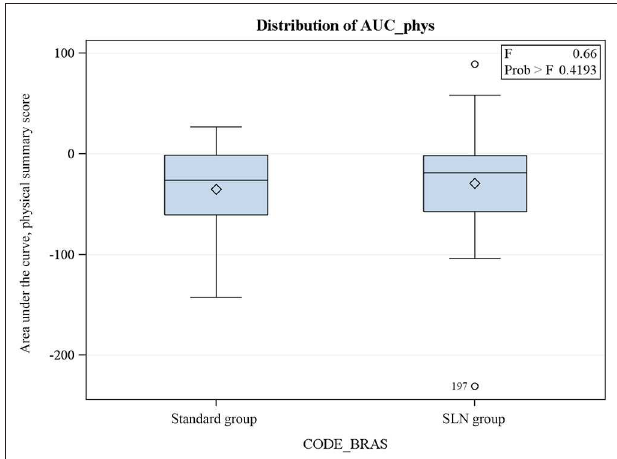
FIGURE 1 | SF36 physical subscore: area under the curve (AUC) of the evolution of the score from the preoperative trough the 3 postoperative visits.